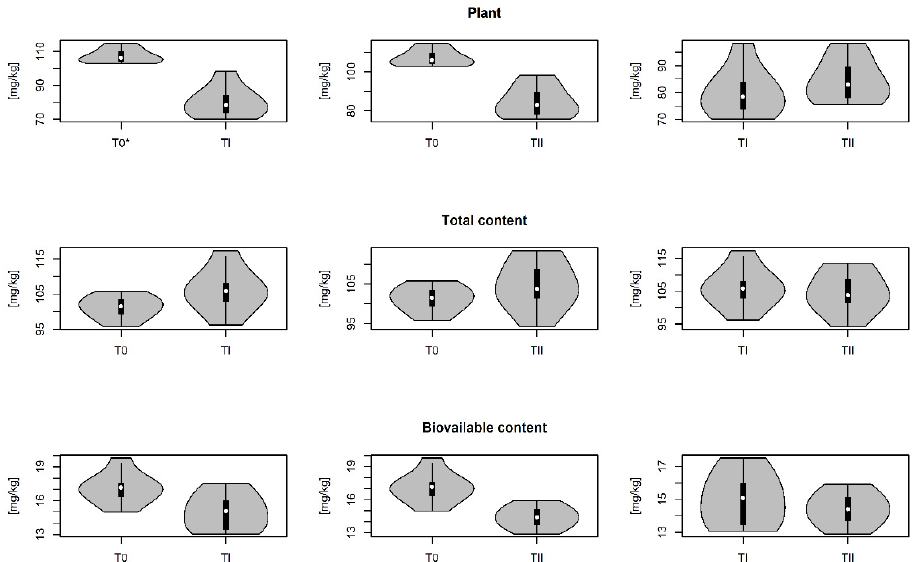
Figure 2. Zn contents in camelina and soil (total and bioavailable amounts) * descriptions see at Material and Methods, statistically significant differences and p -value are presented in Table 2.